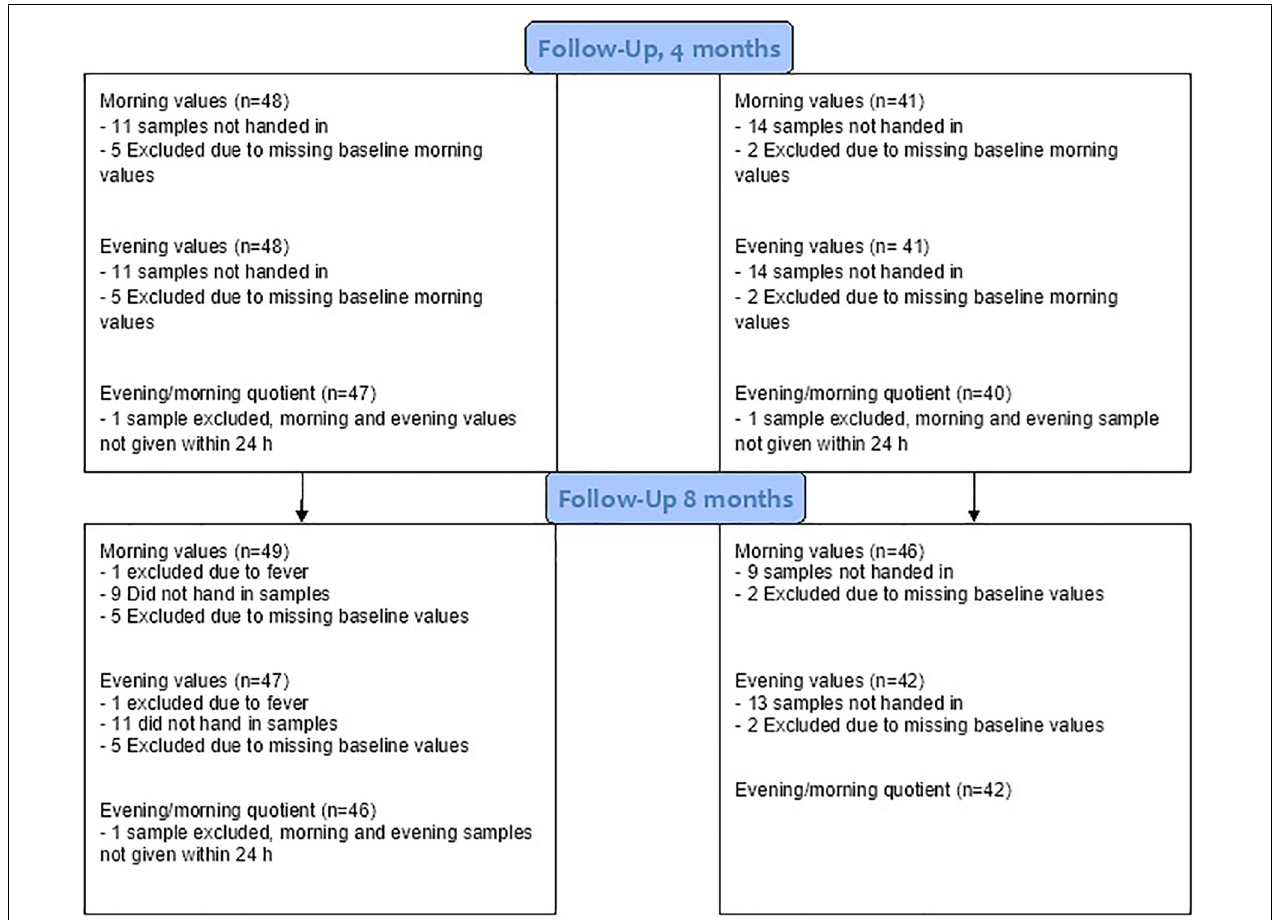
FIGURE 1 | Consort flow